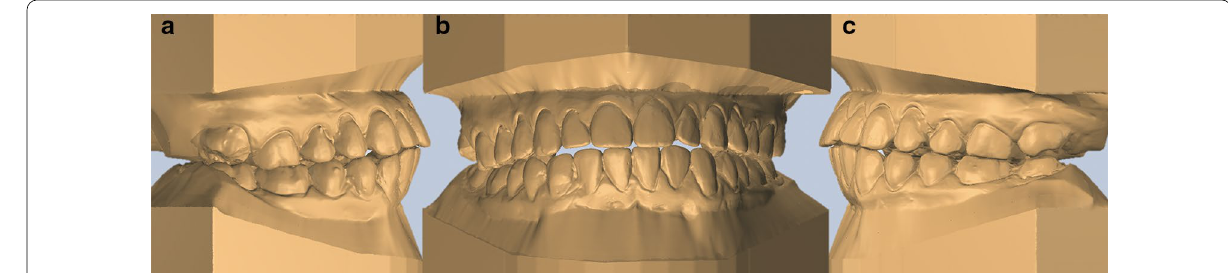
Fig. 1 Case excluded due to poorly finalization. a Right view. b Frontal view. c Left